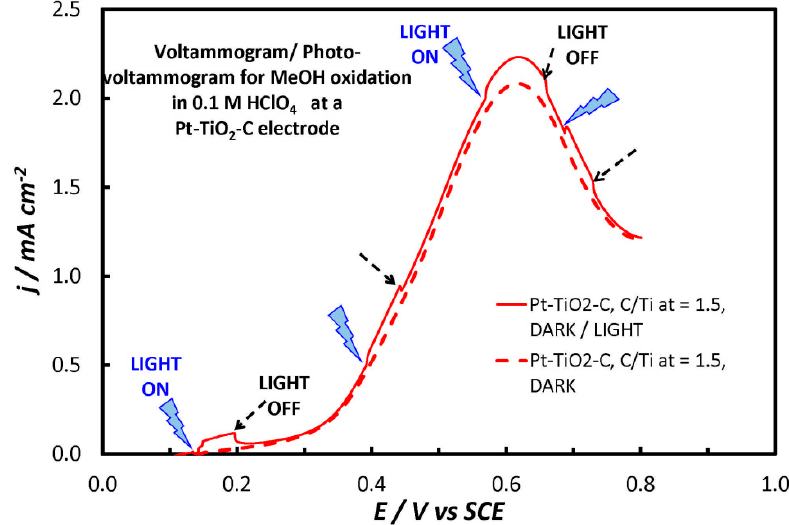
Figure 5. Linear Sweep Voltamograms, LSVs, recorded in 0.1 M HClO 4 + 0.5 M MeOH solutions at a 5 mV s − 1 potential sweep rate (to higher potentials) at a Pt-TiO 2 -C catalyst electrode with a C ÷ Ti atom ratio of 1.5, in the dark and under UV light illumination. Current densities, j, are per cm 2 of electrode substrate.